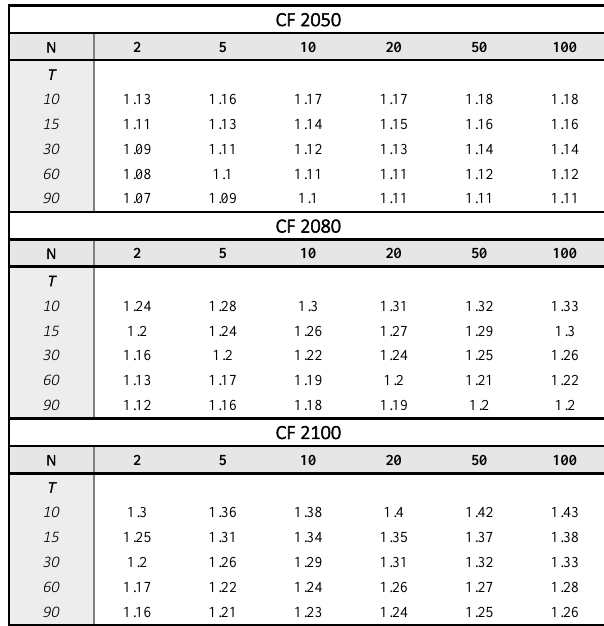
Table 1 . CF values for distinct return period (N) and duration (T) of rainfall intensity grouped for three time horizons.